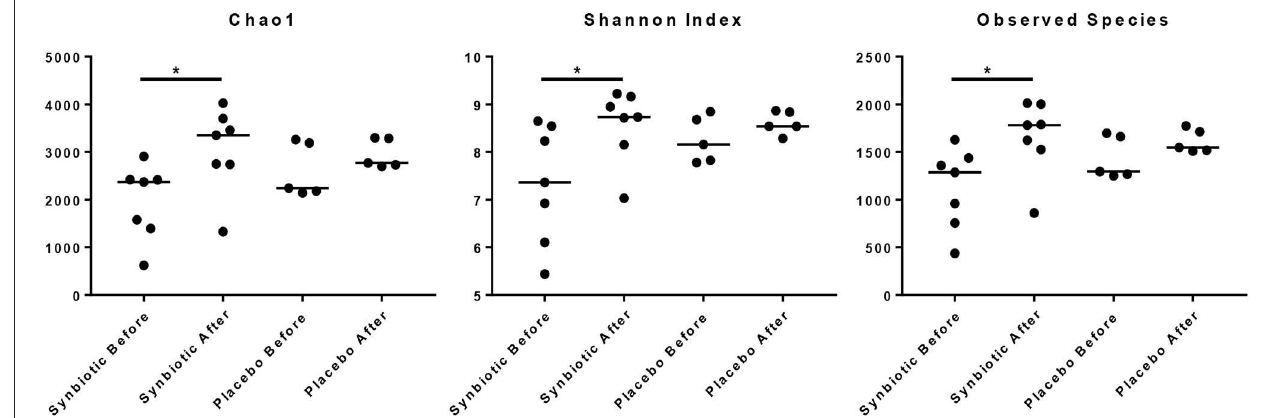
FIGURE 4 | Species richness of fecal samples from dogs with food-responsive chronic enteropathy. Chao1, Shannon index and observed species before and after 6 weeks of treatment with hydrolyzed protein diet and synbiotics are